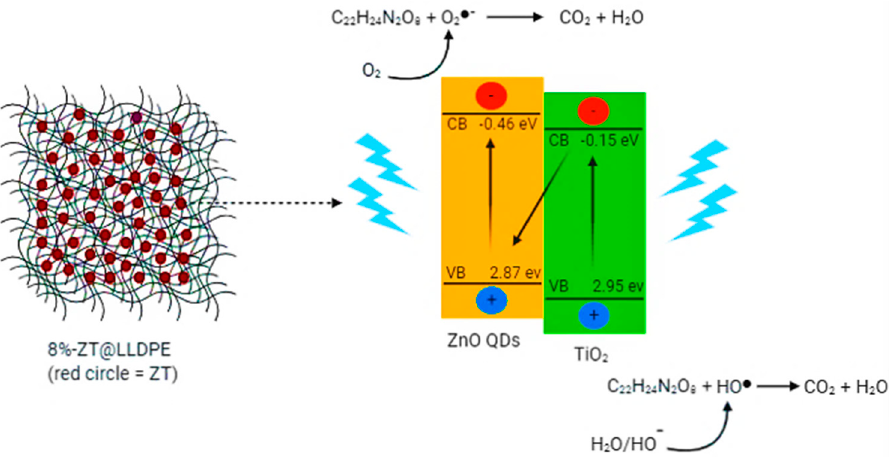
Figure 9. Proposed mechanism for the photocatalytic degradation of TC using 8%-ZT@LLDPE under visible light